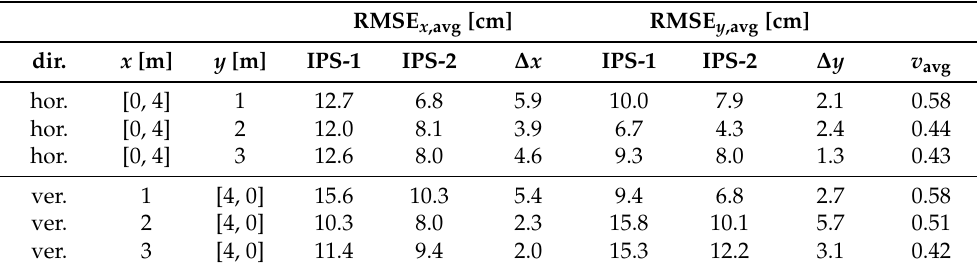
Table 1. Representative results of dynamic validation. The RMSEs of an IPS with and another without DF (IPS-2 and IPS-1, respectively) are compared to demonstrate the accuracy improvement of the former. The average performance difference is shown in columns ∆ x and ∆ y . The average cruise velocity is shown in the last column.